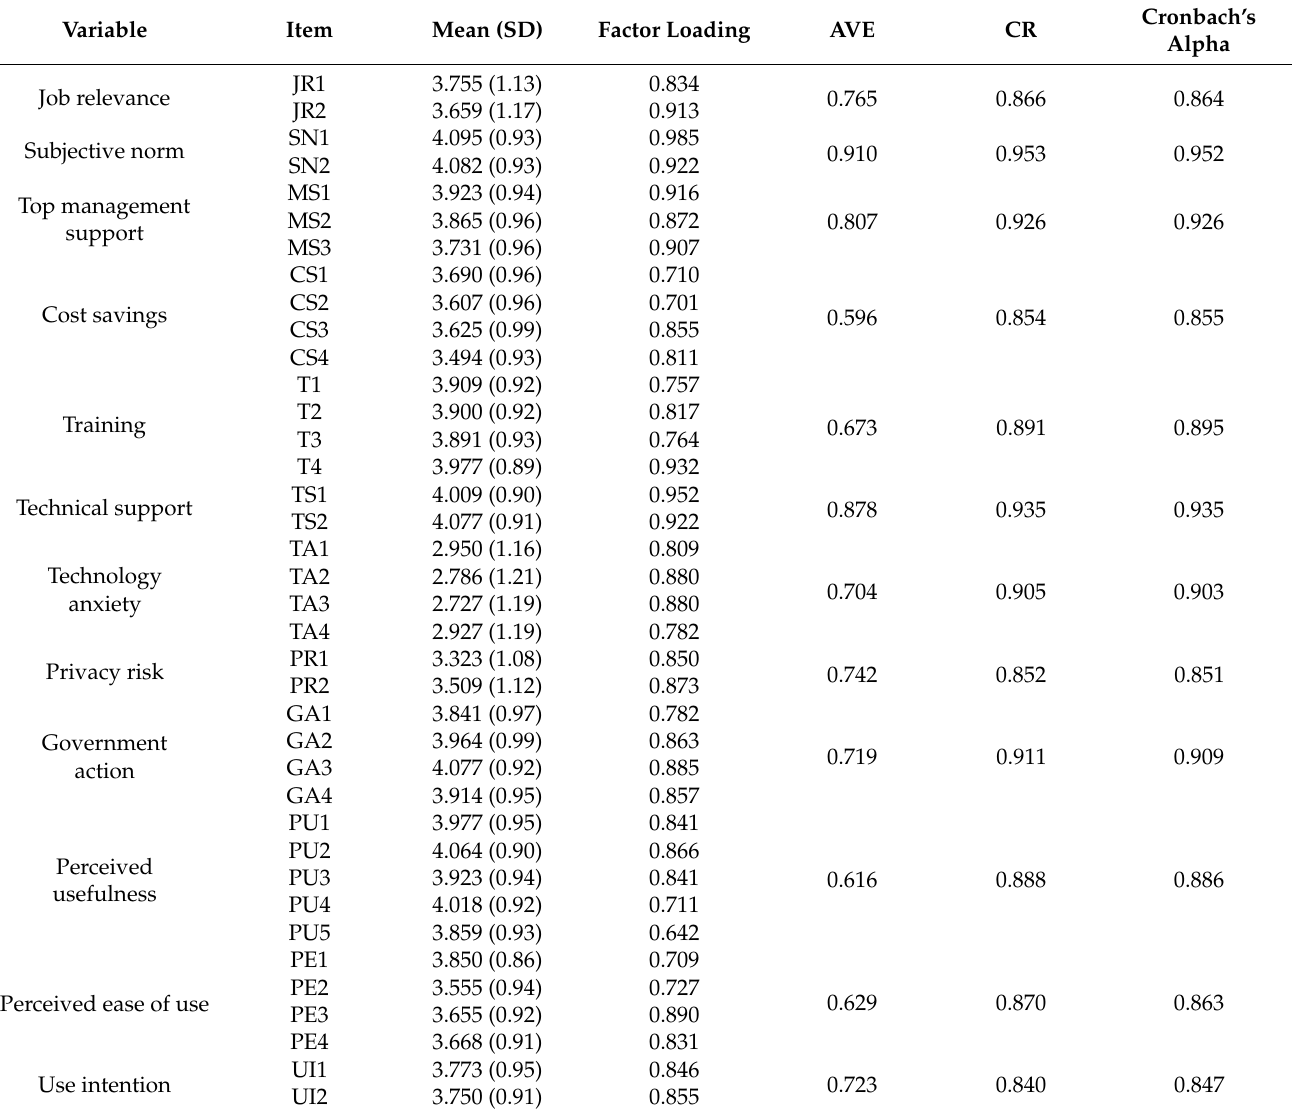
Table 2. Reliability and validity analysis results.